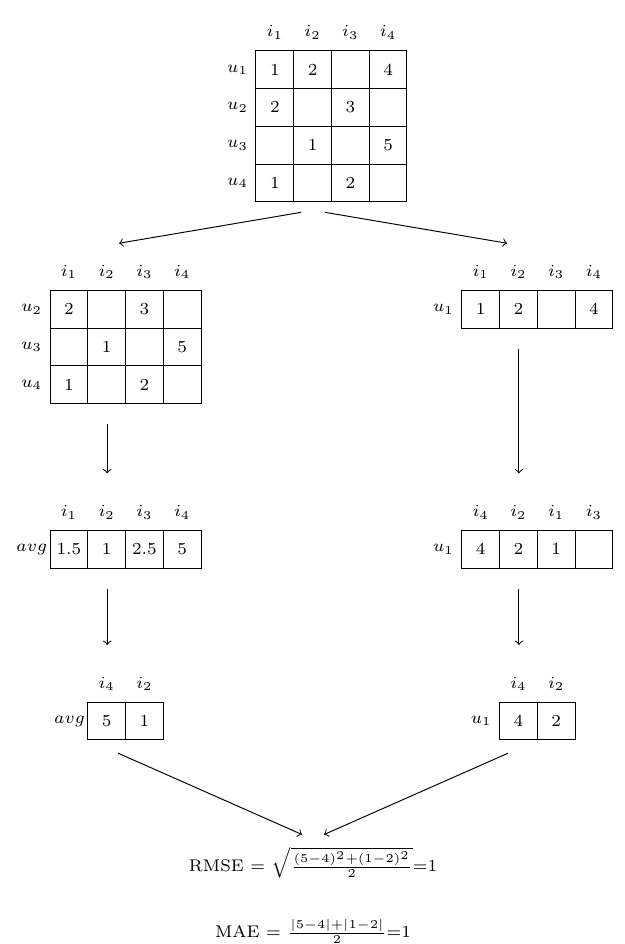
Fig. 6. Example of the rating prediction process based on Community 2 illustrated in Fig. 5. On the ¯rst level, the user – item matrix of a community consisting of u 1 , u 2 , u 3 , and u 4 is given. Since we want to calculate the RMSE and MAE of user u 1 , we split the user – item matrix into two disjoint parts. The left part contains ratings of all community members except for user u 1 . The right part contains only the ratings given by user u 1 . In the next step, we calculate the aggregated ratings given by all remaining users (i.e., left part) to items i 1 , i 2 , i 3 , and i 4 . Finally, to calculate the RMSE and MAE, we considered only the top k ¼ 2 highest-rated items of user u 1 and compared their ratings with u 1 's original RMSE for this case is better (i.e., 1 : 19 ). Generally, our approach shows an im- provement of both applied metrics, except for the case in which we considered age, occupation, and zip code of users to build the social graph. To conclude, the com- munity seems to share very similar taste about the rated items of the unknown user. Therefore, it seems to be an appropriate solution for the cold-start problem to rely on the taste of the community and recommend, for instance, the top 10 items based on the aggregated ratings of the community.